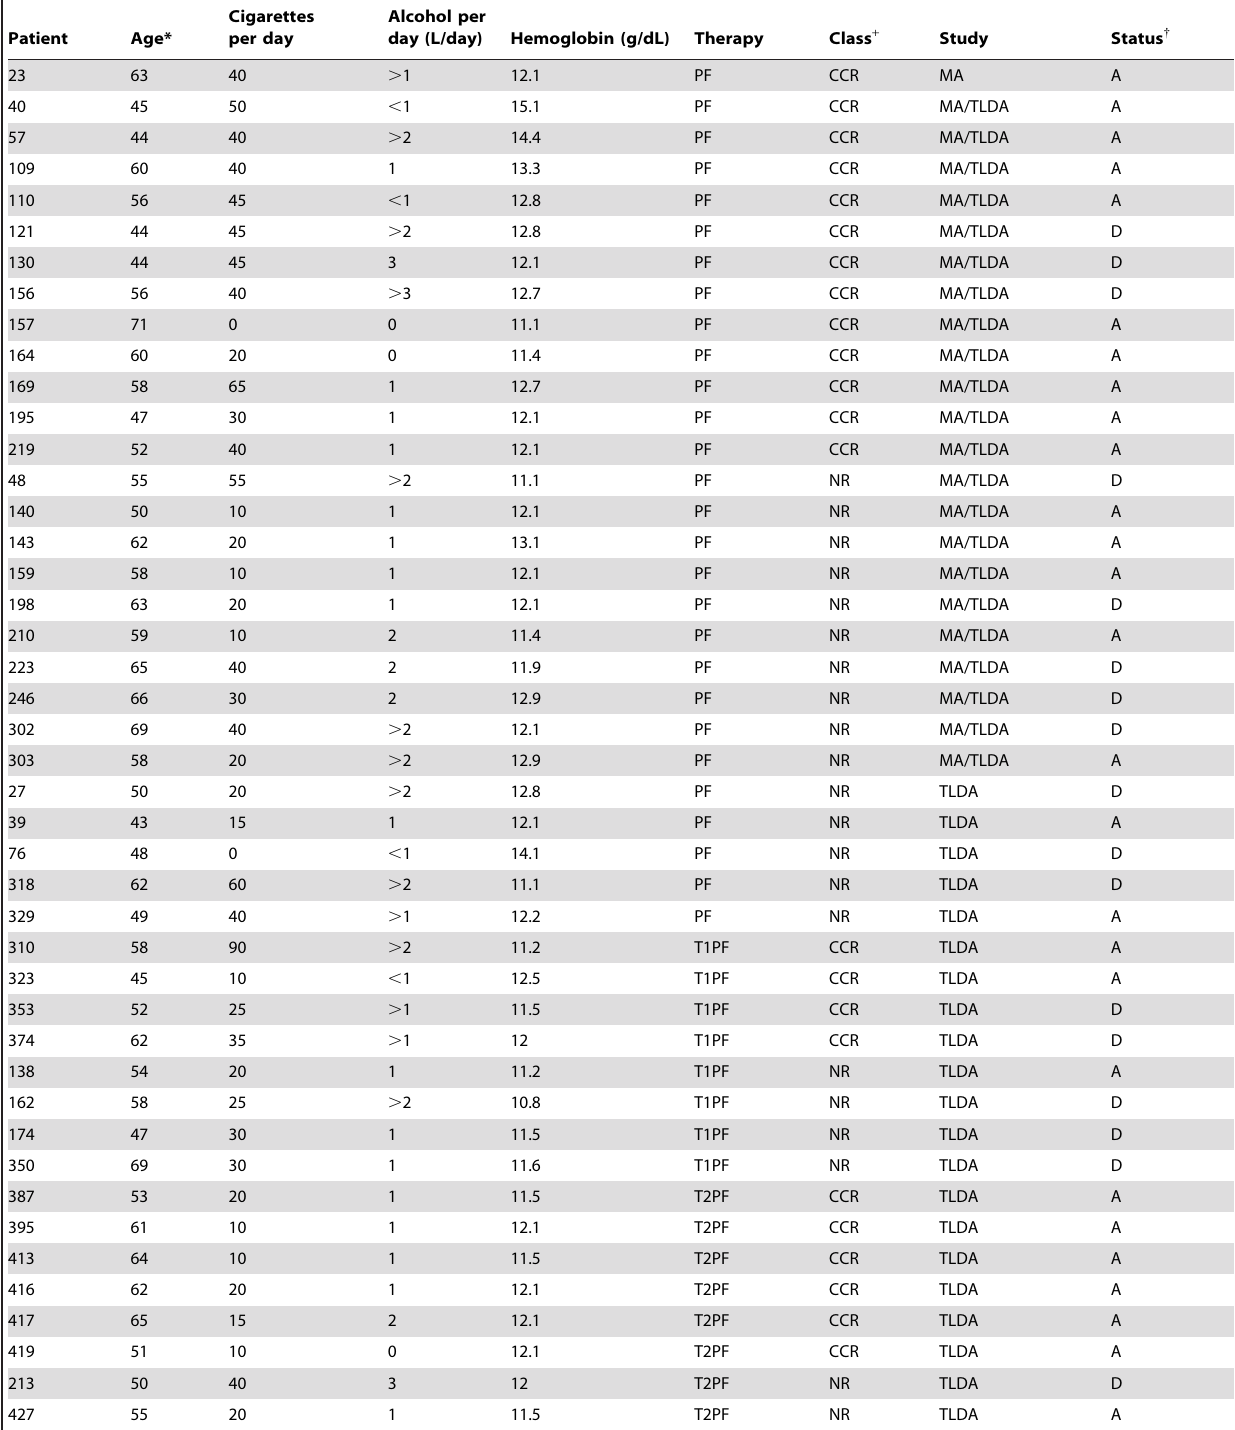
Table 1. Patient